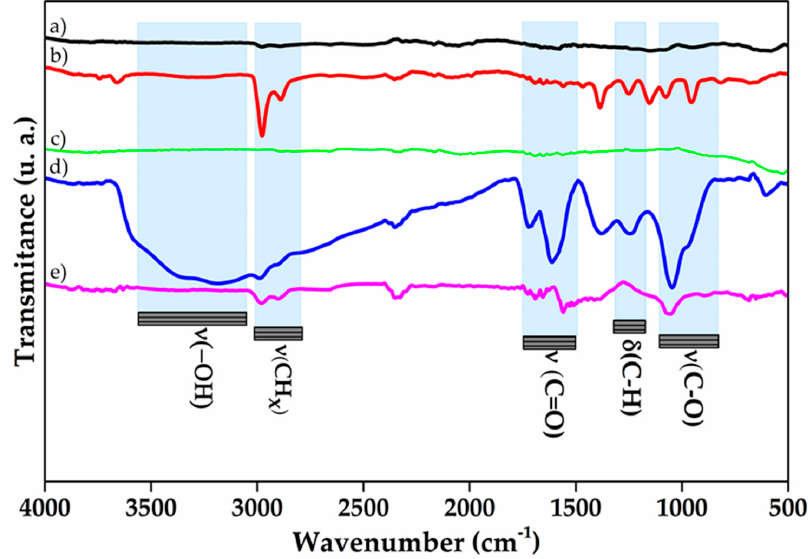
Figure 1. Infrared spectrum of nanocarbon forms: ( a ) pristine MWCNT (multi-walled carbon nanotubes); ( b ) O-MWCNT (oxidized multi-walled carbon nanotubes); ( c ) GRA (graphite); ( d ) GO (graphene oxide); and ( e ) RGO (reduced graphene oxide).